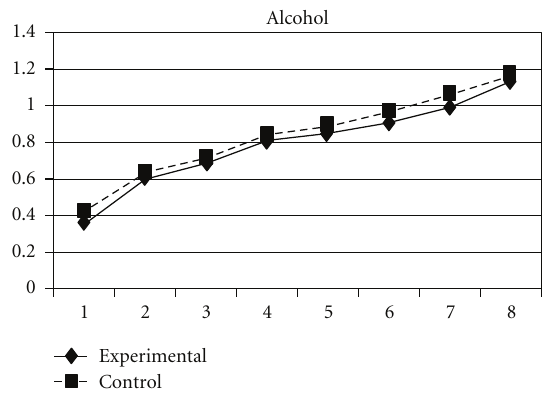
Figure 16: Growth trajectories of the experimental group (partic- ipants who perceived the program as e ff ective) and control group using the scale score of problem behavior intention as the outcome indicator.